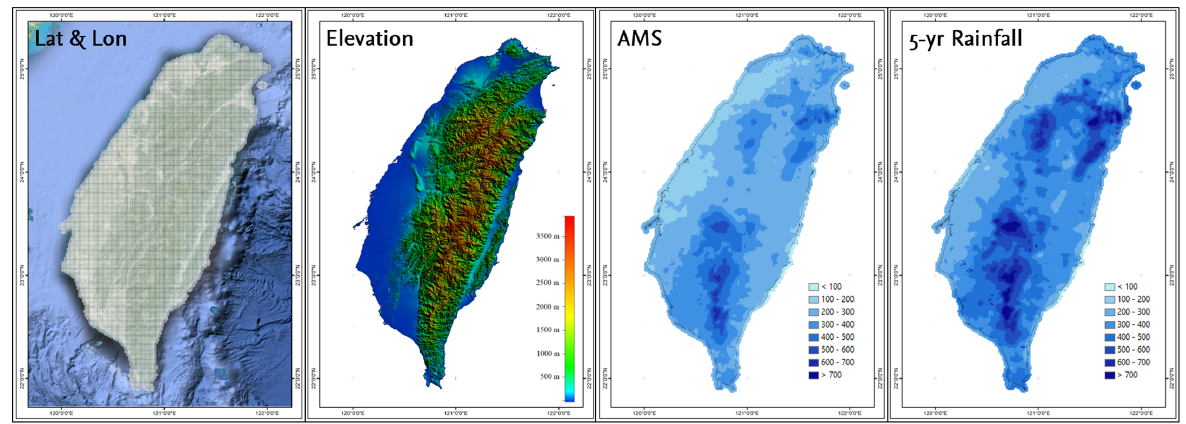
Figure 3. Site ‐ characteristics used in K ‐ means clustering (Latitude and Longitude, Elevation, The Figure 3. Site-characteristics used in K-means clustering (Latitude and Longitude, Elevation, The average of Annual Maximum Series, and 5 ‐ year Rainfall. average of Annual Maximum Series, and 5-year